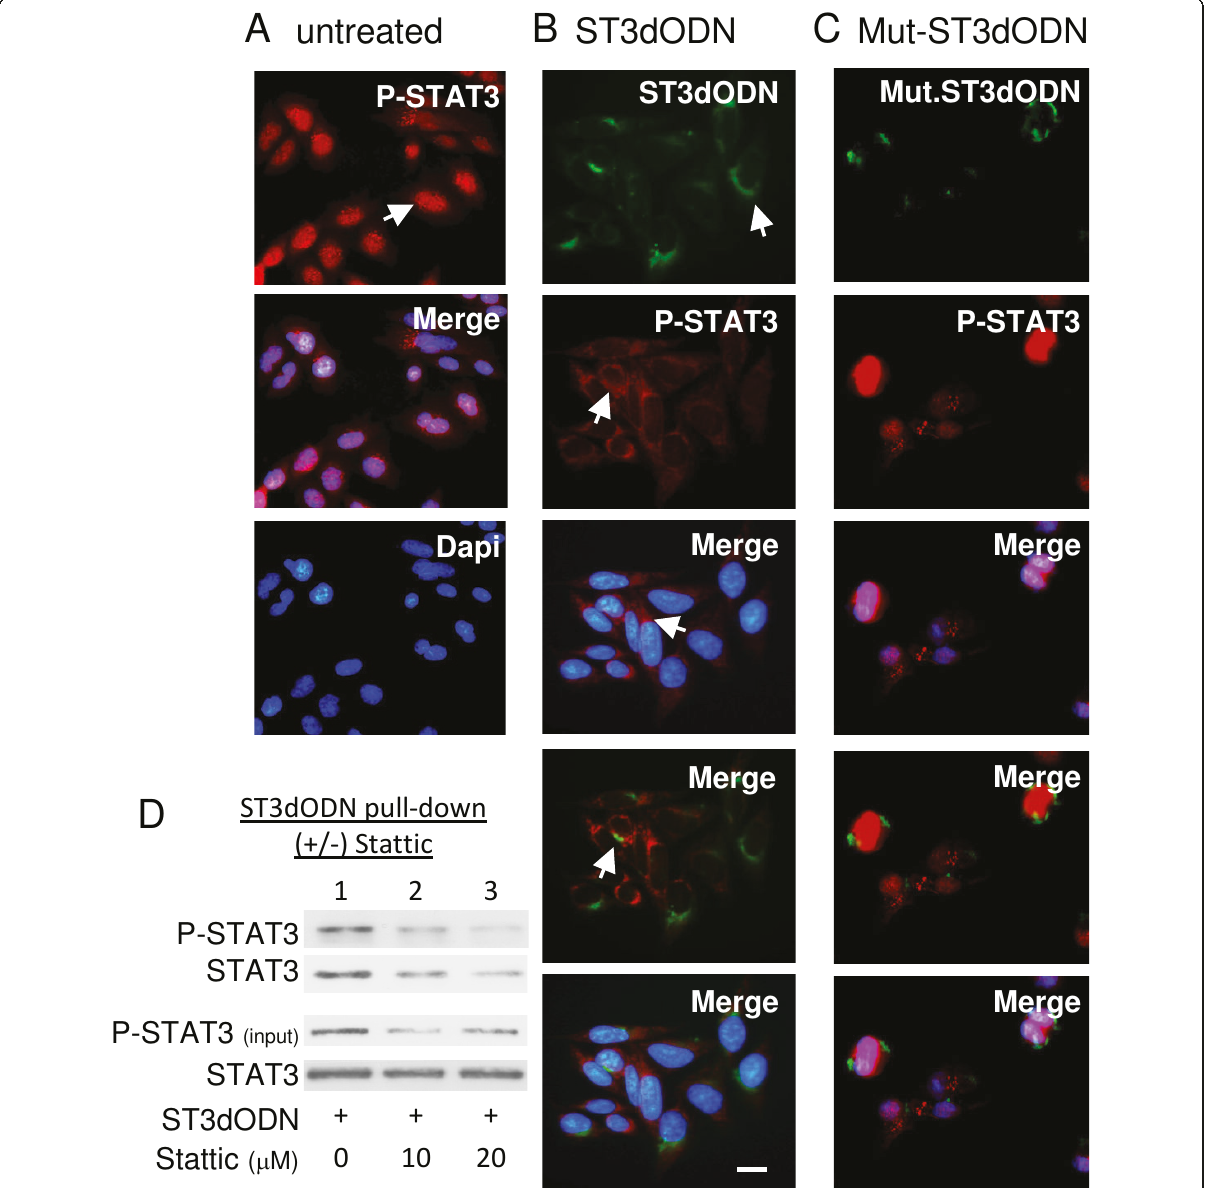
Figure 2 Inhibition of phospho-STAT3 nuclear localization by STAT3-decoy ODN . Immunofluorescence microscopy analysis: A : nuclear localization of phospho-STAT3 (red) in non-treated SW 480 cells. Cells were fixed and labelled with anti-phosphotyrosine 705-STAT3 antibody and counterstained with 4 ’ ,6 ’ -diamidino-2-phenylindole (Dapi); B : cytoplasmic localization of phospho-STAT3 (red) in STAT3-decoy ODN- transfected (2 μ g/ml) SW480 cells; FITC-labeled STAT3-decoy ODN was detected in the cytoplasm (green), and cells counterstained with Dapi; C : nuclear localization of STAT3 (red) in mutated STAT3-ODN- transfected (2 μ g/ml) SW480 cells; FITC-labeled mutated STAT3-ODN was detected in the cytoplasm (green), cells were counterstained with Dapi. Scale bar: 10 nm. In-cell STAT3-decoy ODN pull-down assays: D : Cells were transfected with biotinylated STAT3-decoy ODN, after cell lysis and recovery on avidin-Sepharose beads, complexes were subjected to western blotting using an anti-phospho-STAT3 antibody. Cells were either not treated (1) or treated with Stattic, 10 μ M (2) or 20 μ M